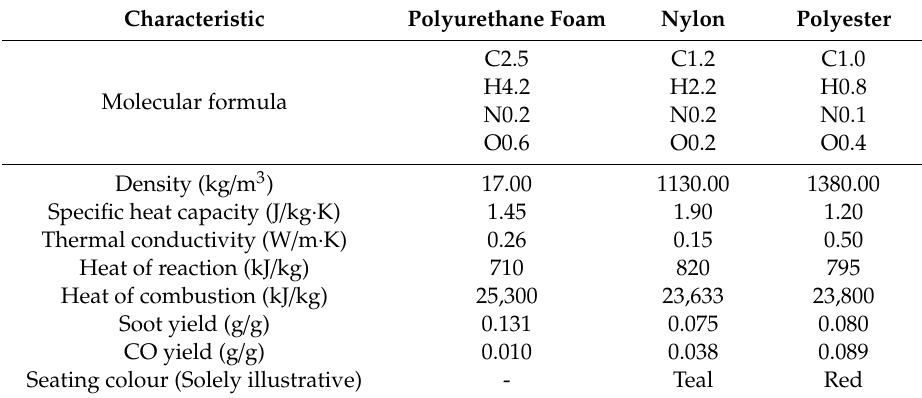
Table 2. Properties of materials